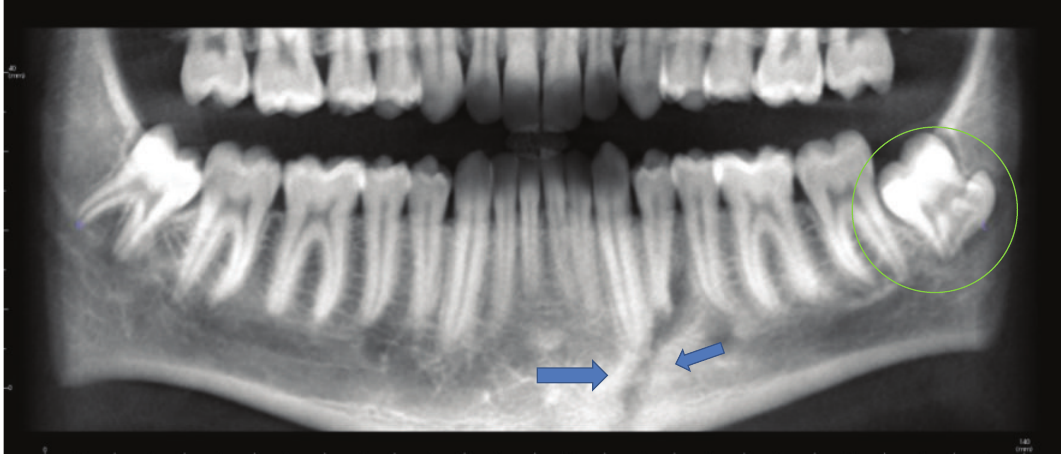
Figure 3: Panoramic radiograph showing concrescence in the lower left third molar region (green circle); additionally, fracture line (blue arrows) is noted in the premolar region (left side).